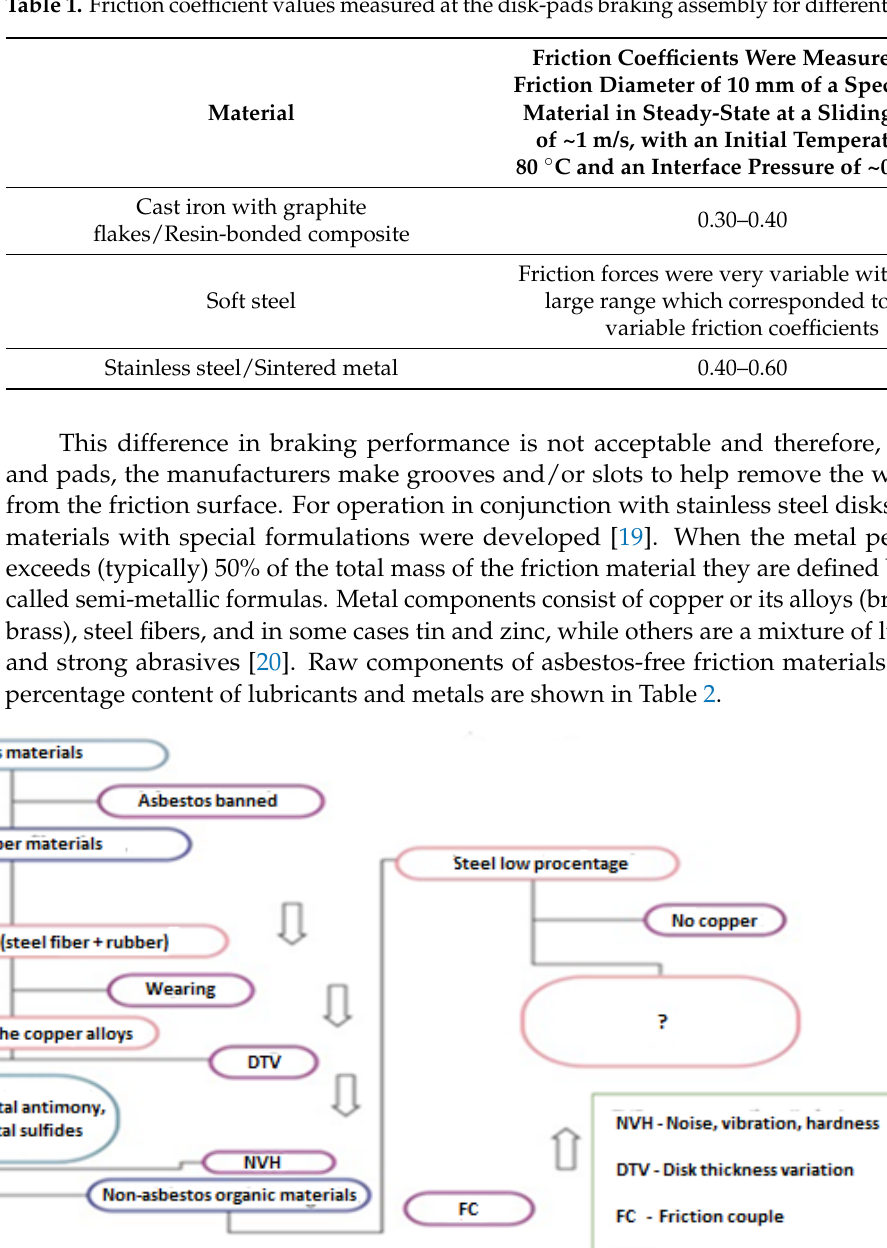
Table 1. Friction coefficient values measured at the disk-pads braking assembly for different materials.